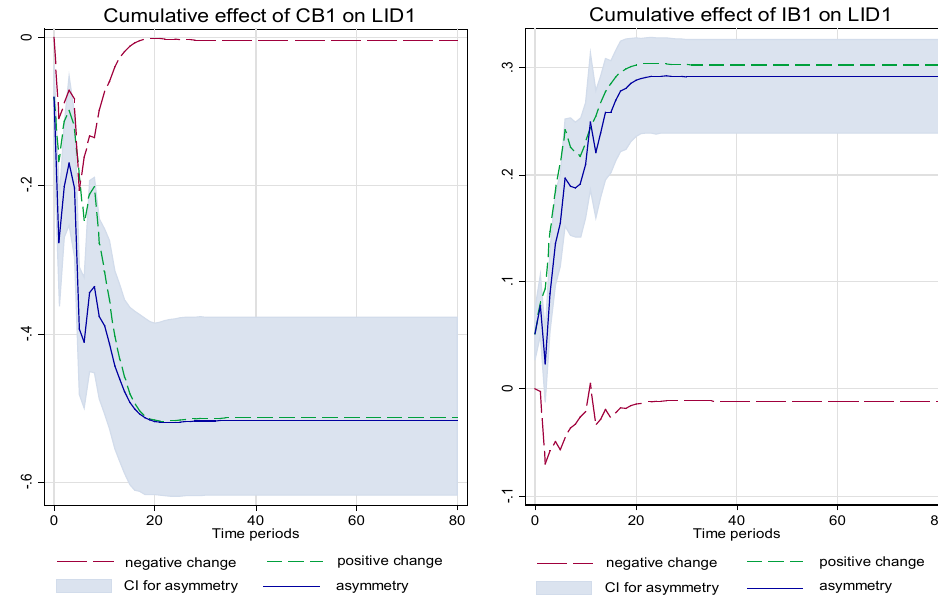
Figure 1. Dynamic multipliers, 1-month maturity